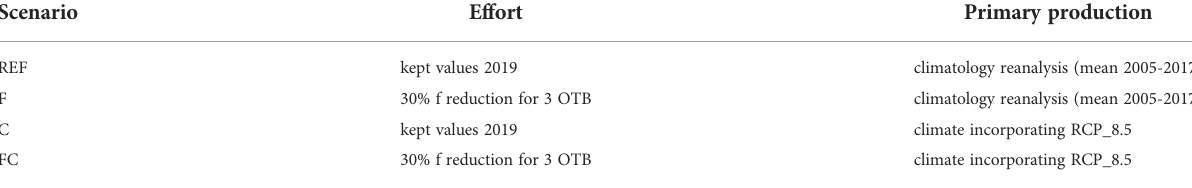
TABLE 3 Breakdown of forcing used to the reference (REF) and the alternative projected scenarios, F= fi shing effort reduction, C= climate, FC= fi shing effort reduction+climate.